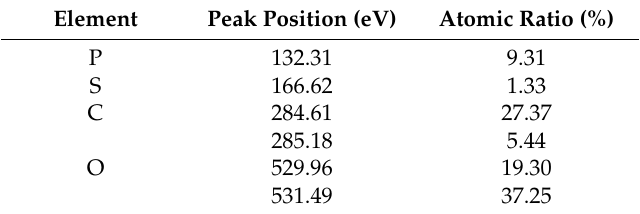
Table 2. Electron binding energy and atomic ratio of main elements on P-KC surface.